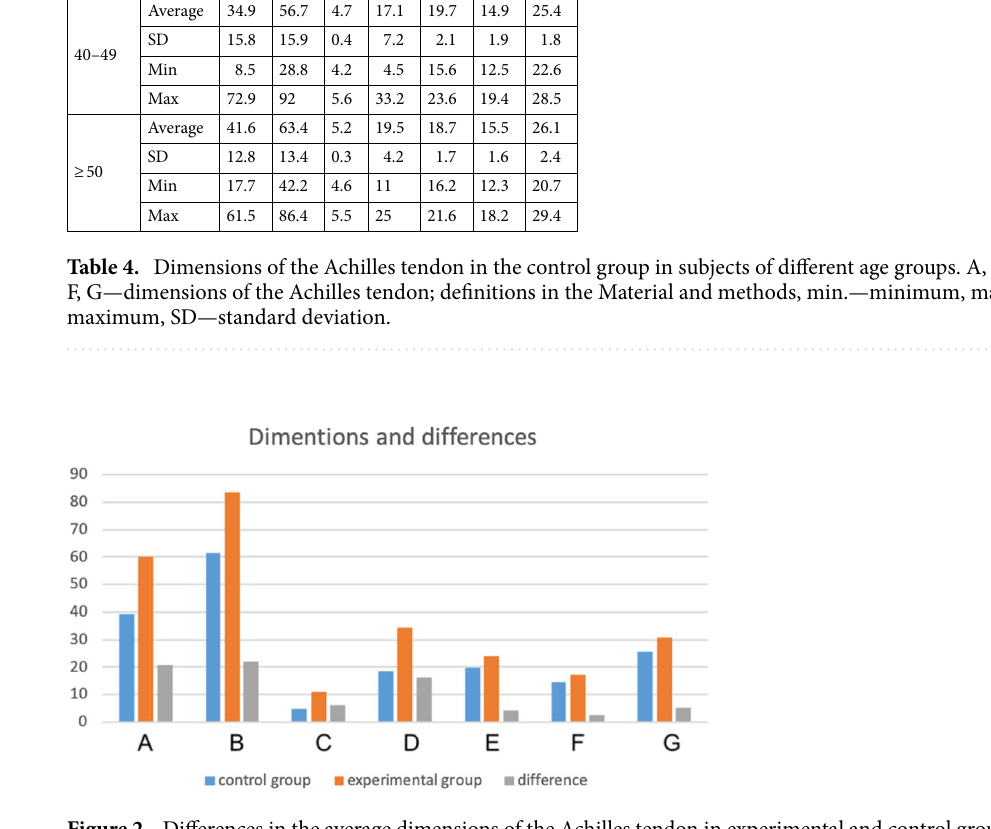
Figure 2. Differences in the average dimensions of the Achilles tendon in experimental and control group. The vertical axis represents millimeters, horizontal axis represents dimensions A–G; definitions are in the Material and Methods. The figure was prepared in Excel (version